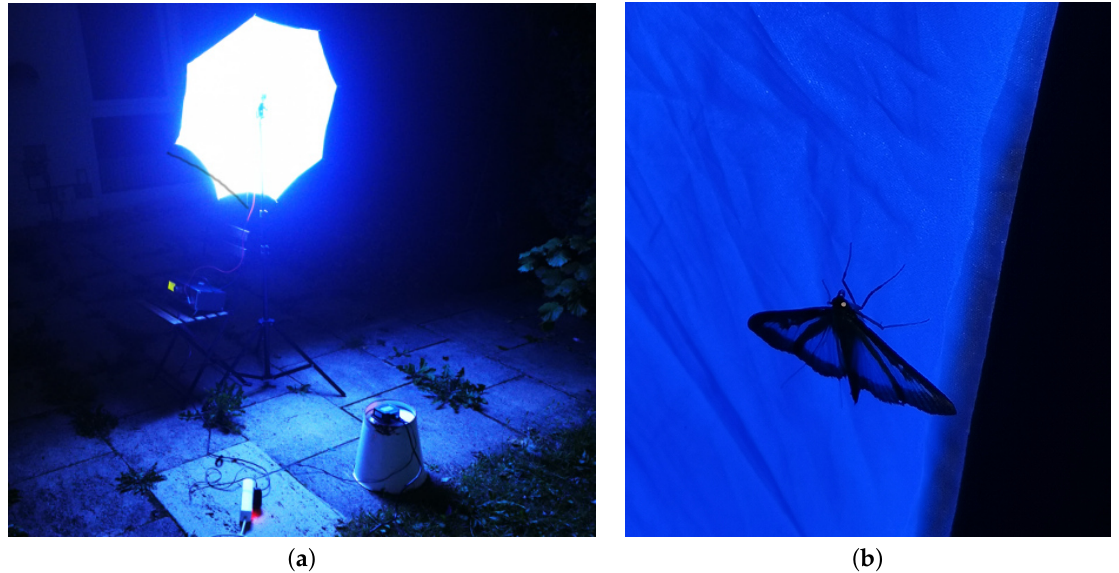
Figure A1. Experiment 0: ( a ) the setup, ( b ) a sample photo with an insect. In order to detect insect targets, we analyzed the collected photos and radar